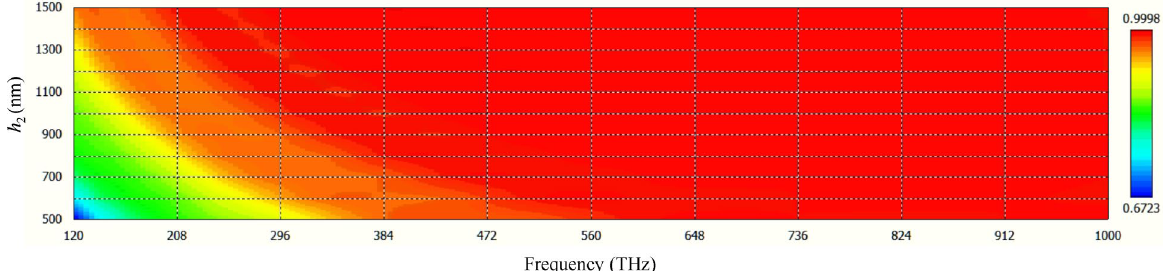
Figure 7. The absorption rate of the proposed solar cell for different cone heights h 2 .